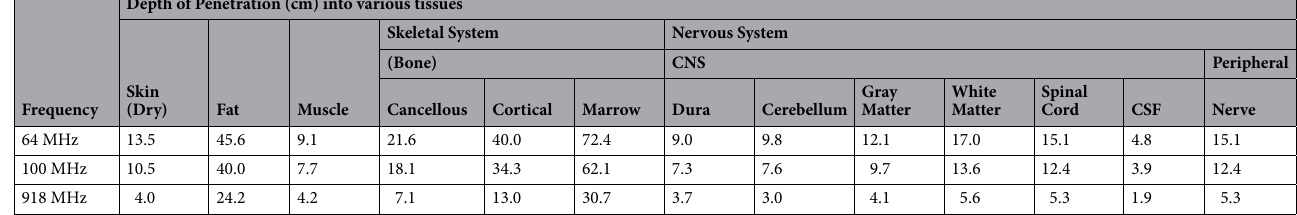
Table 1. Electromagnetic frequencies and human tissue penetration 77